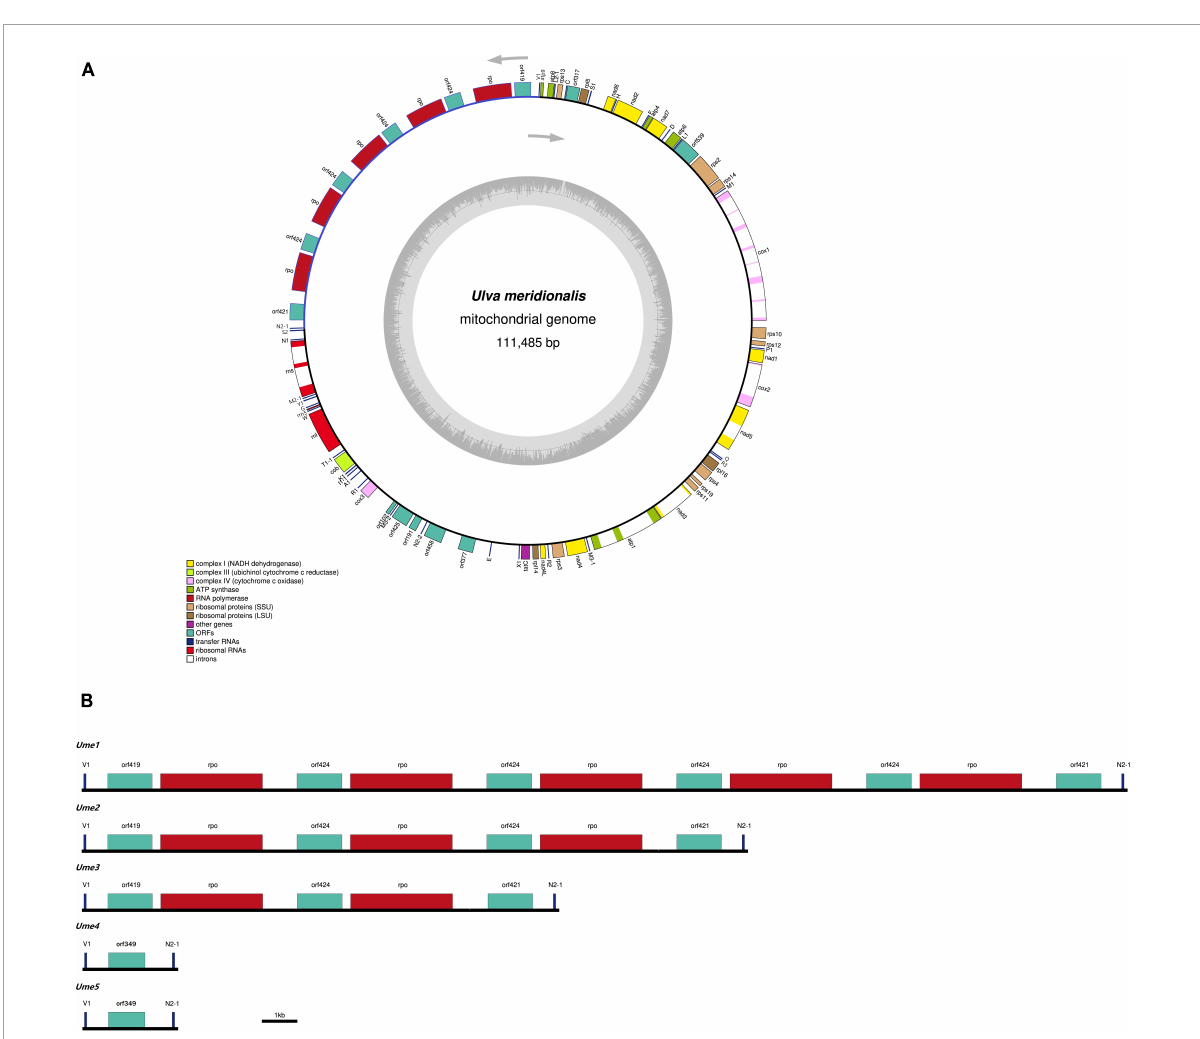
FIGURE1 The mitochondrial genomes of Ulva meridionalis . (A) Gene map of the largest U. meridionalis mitochondrial genome ( Ume1 ). Genes ( filled boxes ) shown on the outside of the map are transcribed counterclockwise. The smaller circle on the inside of the gene mapping shows a graph of the GC content. Genes are color coded for their functional gene group (legend bottom left). (B) Variations in the trnV1-trnN2-1 intergenic region of five U. meridionalis mitogenomes ( Ume1 – Ume5 ) due to the tandem integration of circular plasmid